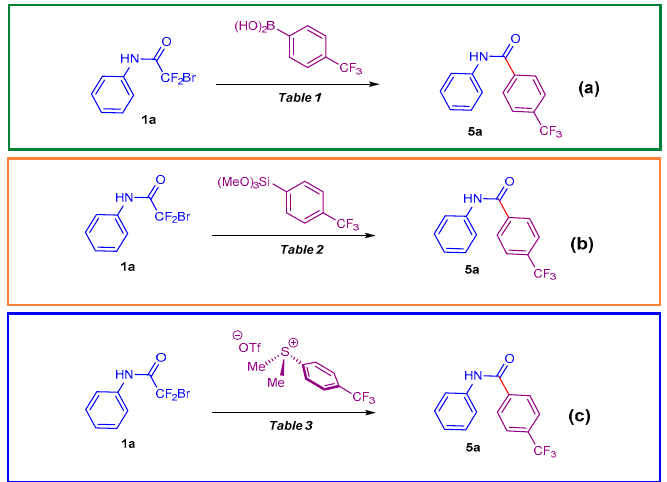
Scheme 2. Model reactions for reaction conditions optimization: ( a ) Reaction of 2-bromo-2,2- difluoro- N -phenylacetamide with (4-(trifluoromethyl)phenyl)boronic acid, ( b ) Reaction of 2-bromo- 2,2-difluoro- N -phenylacetamide with trimethoxy(4-(trifluoromethyl)phenyl)silane, ( c ) Reaction of 2-bromo-2,2-difluoro- N -phenylacetamide with dimethyl(4-(trifluoromethyl)phenyl)sulfonium tri- flate.